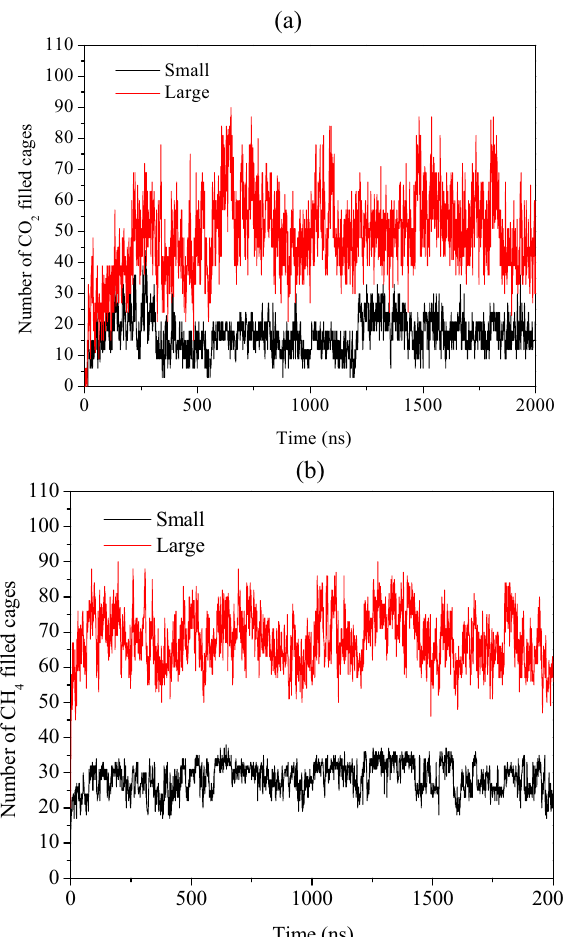
Figure 7. Plot of number of filled cages of ( a ) CO 2 and ( b ) CH 4 hydrates during the CH 4 –CO 2 replacement dynamics in presence of free water molecules, carbon dioxide and salt ions with operating pressure and temperature of 50 MPa and 260 K,